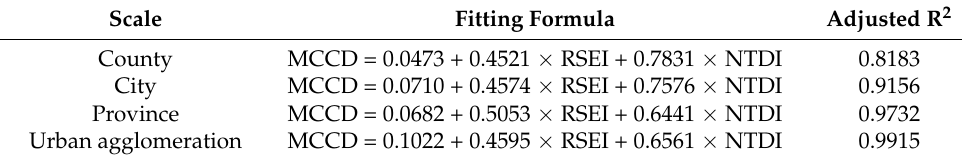
Table 4. Fitting formulas of the RSEI, NTDI and MCCD at different